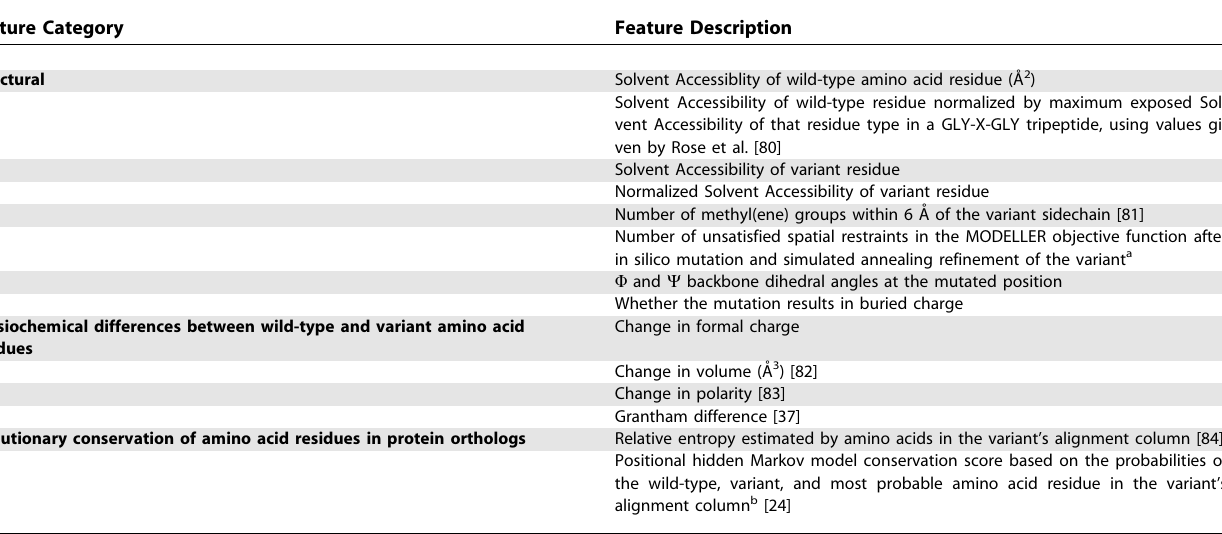
Table 2. Predictive Features Describing Evolutionary Conservation, Impact of Mutation on Protein Structure, and Amino Acid Residue Properties Used as Input to the Computational Supervised Learning Algorithms Feature